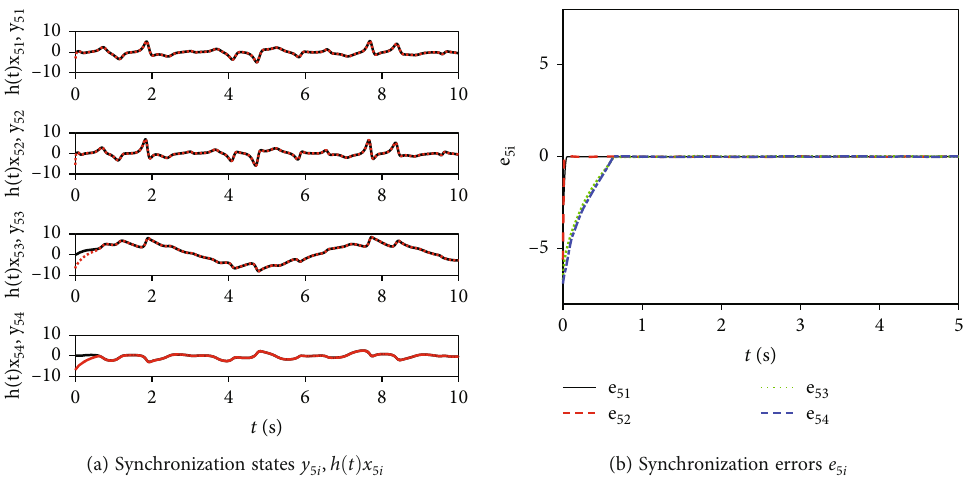
Figure 12: The time evolution of synchronization between y